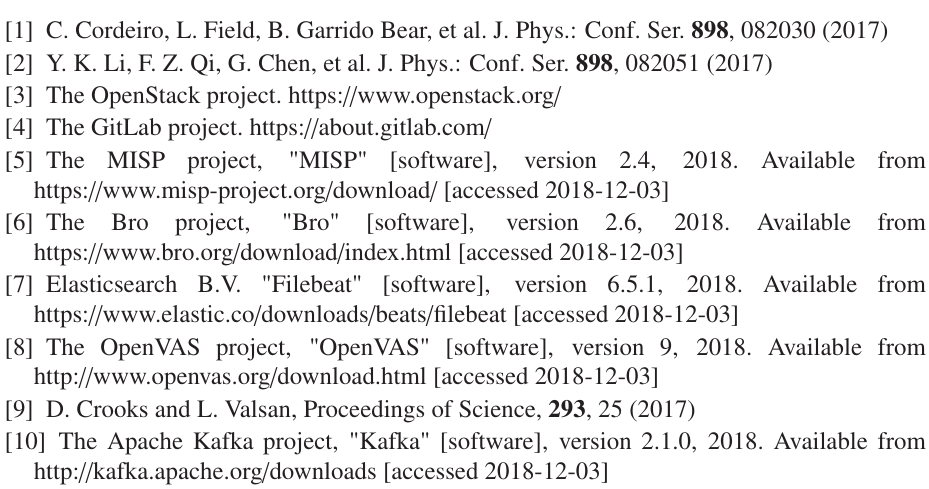
Figure 4. Architecture of security detection and monitoring